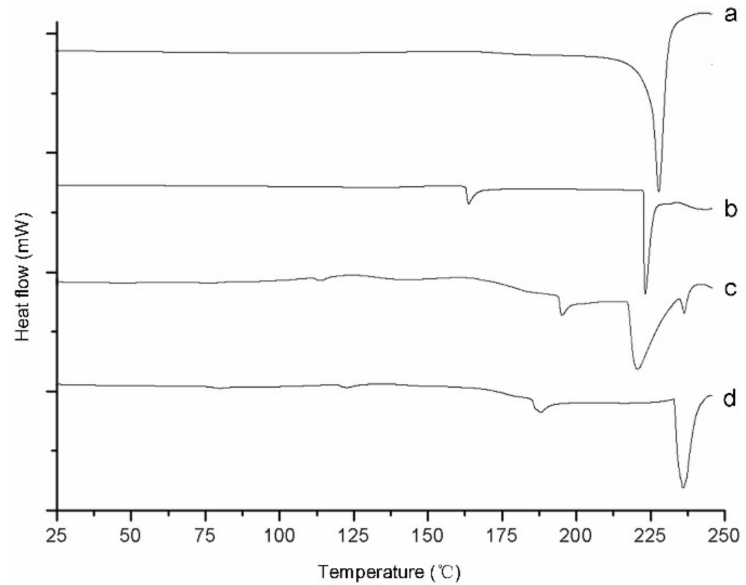
Figure 3. Differential scanning calorimetry (DSC) curves of astaxanthin ( a ); astaxanthin-loaded nanoliposomes ( b ); SPC ( c ) and physical mixture of astaxanthin and SPC ( d